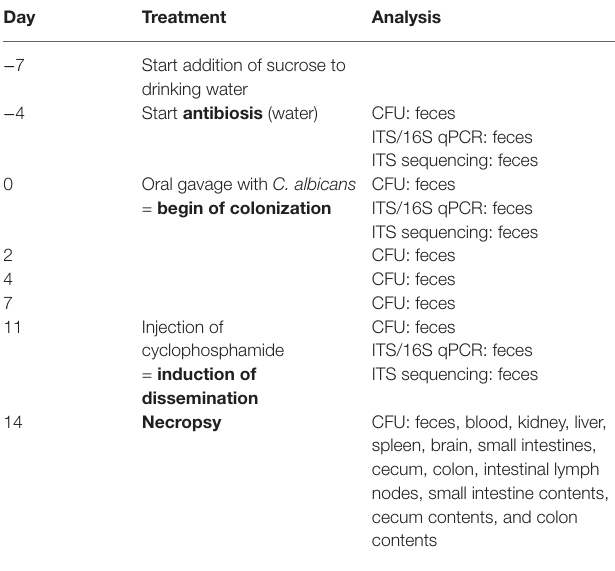
TABLE 1 | Overview of treatments for the colonization/dissemination